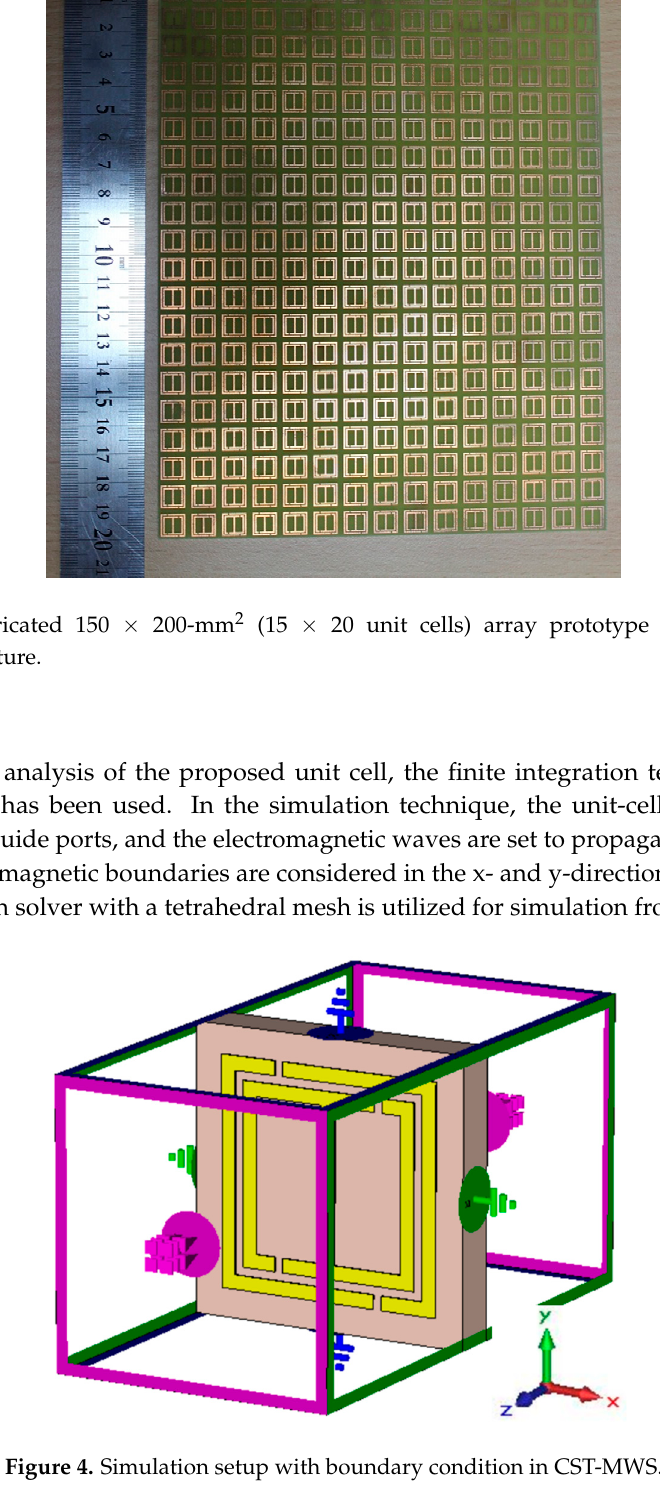
Figure 2. Meta-atom unit cell: ( a ) proposed structure, ( b ) fabricated structure.